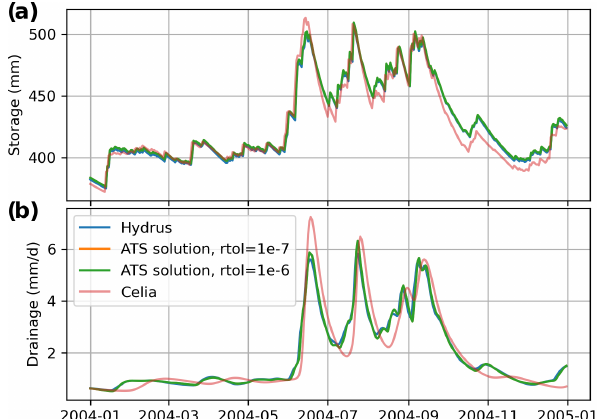
Figure 7. Simulated storage (a) and drainage (b) using Hydrus 1D, the ATS solution, and our implementation of Celia’s MPM